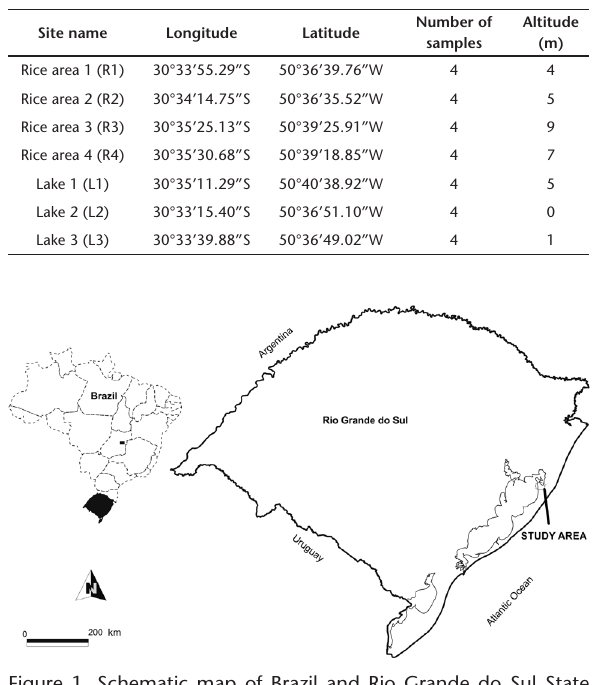
Table 1. Seven sampled areas with geographical coordinates and numbers of samples collected between January to March 2015.